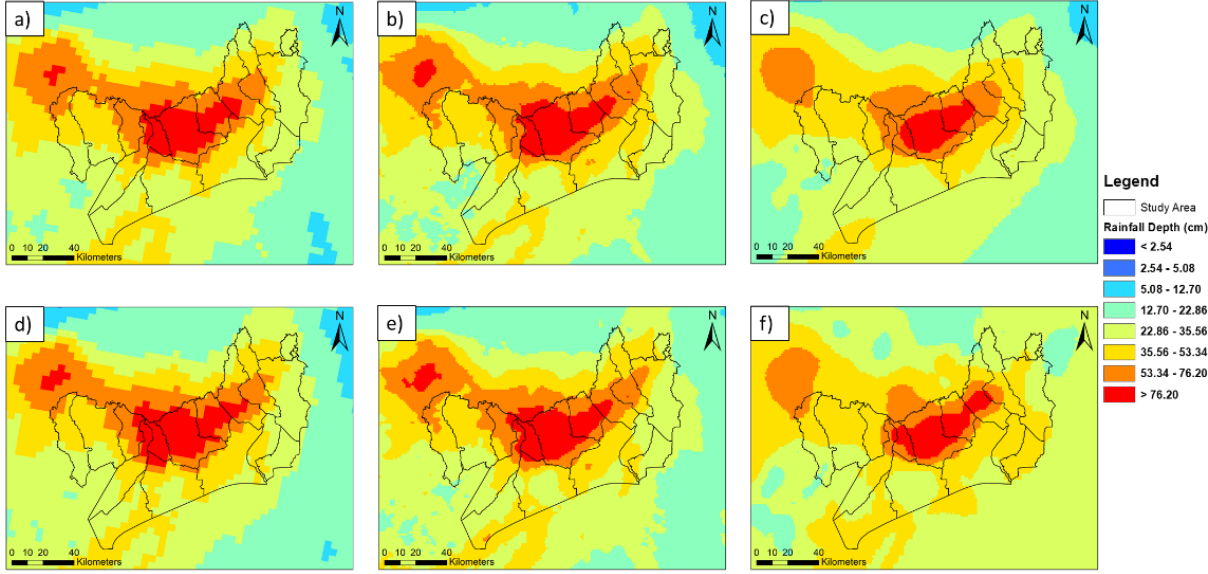
Figure 7. Precipitation maps from merged radar-gauge data of ( a ) Stage IV, ( b ) MRMS, ( c ) RTMA using BRK method, ( d ) Stage IV, ( e ) MRMS, ( f ) RTMA using RK method during Tropical Storm Imelda.